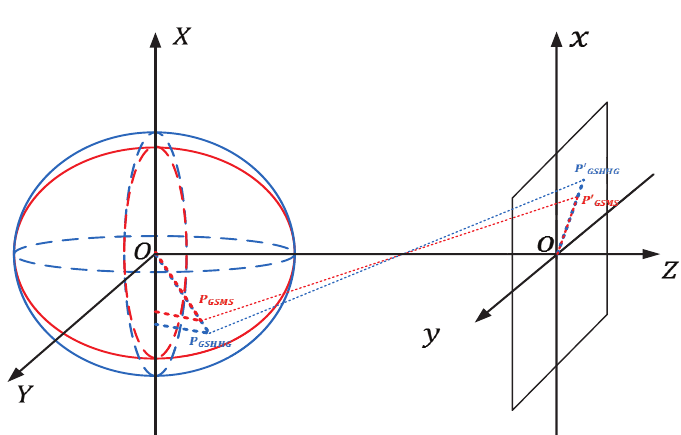
Figure 4. The illustration of local translation between GSMS images and landmark images. The blue sphere is a standard projection model for landmark images and the red spheroid is an earth model for GSMS images. The projection transformation preserves lines, thus there is radial translation between P (cid:48) and P (cid:48) . GSHHG GSMS